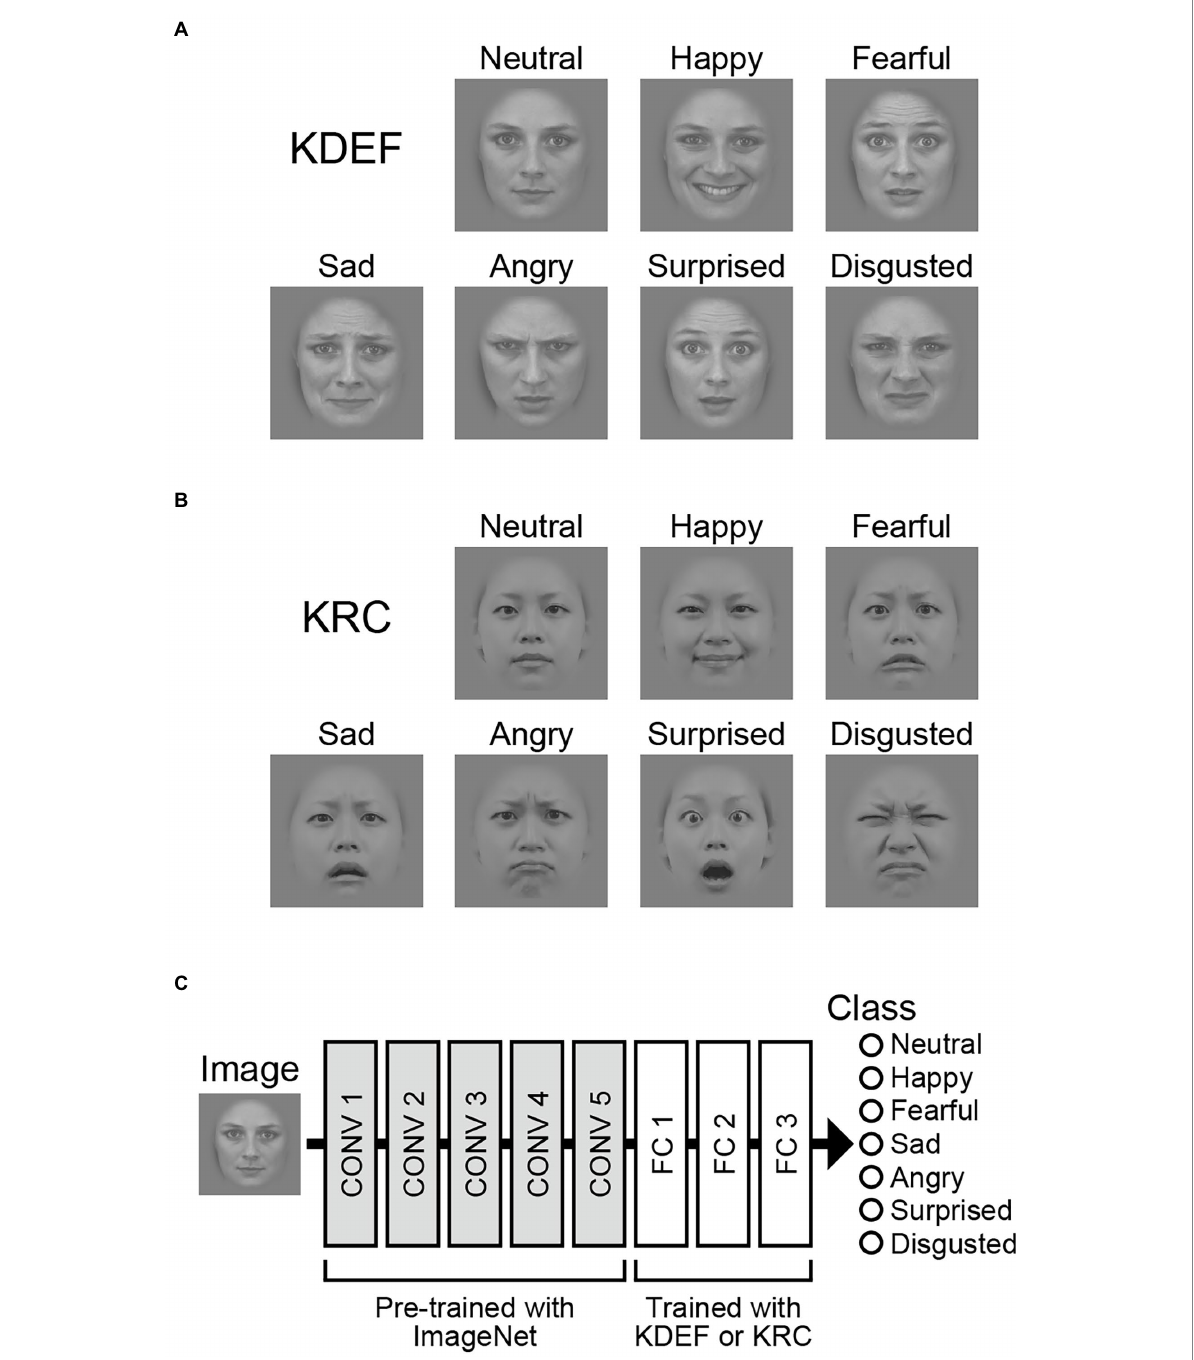
FIGURE 1 Input images and the architecture of the CNN. Example images of seven facial expressions in the KDEF database (A) and those in the KRC database (B) . Examples are BF01NES, BF01HAS, BF01AFS, BF01SAS, BF01ANS, BF01SUS, and BF01DIS from the KDEF database, and fd19_neu_d, fd19_hap_d, fd19_fea_d, fd19_sad_d, fd19_ang_d, fd19_sur_d, and fd19_dis_d from the KRC database. The CNN consisted of five convolutional (CONV) layers and three fully connected (FC) layers (C) . The weights of the convolutional layers were adopted from “AlexNet,” which was pre-trained for classification of object images in the ImageNet database (Russakovsky et al., 2015). We trained our CNNs to optimize the weights of the FC layers to classify the seven facial expressions through the experimental